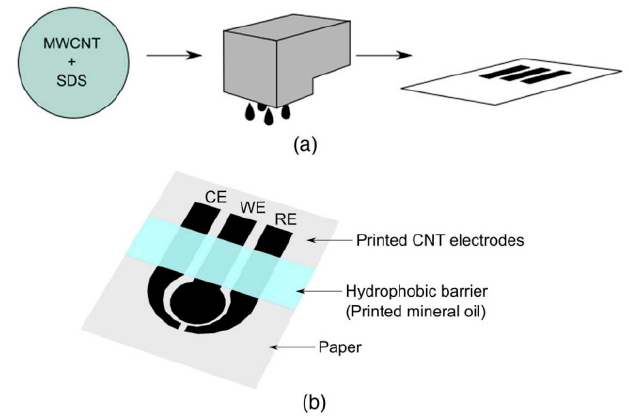
Figure 6. Illustration of the fully inkjet-printed electrochemical sensor developed by da Costa et al.: ( a ) Fabrication process; ( b ) Schematic diagram of the completed sensor. Reproduced from [15].